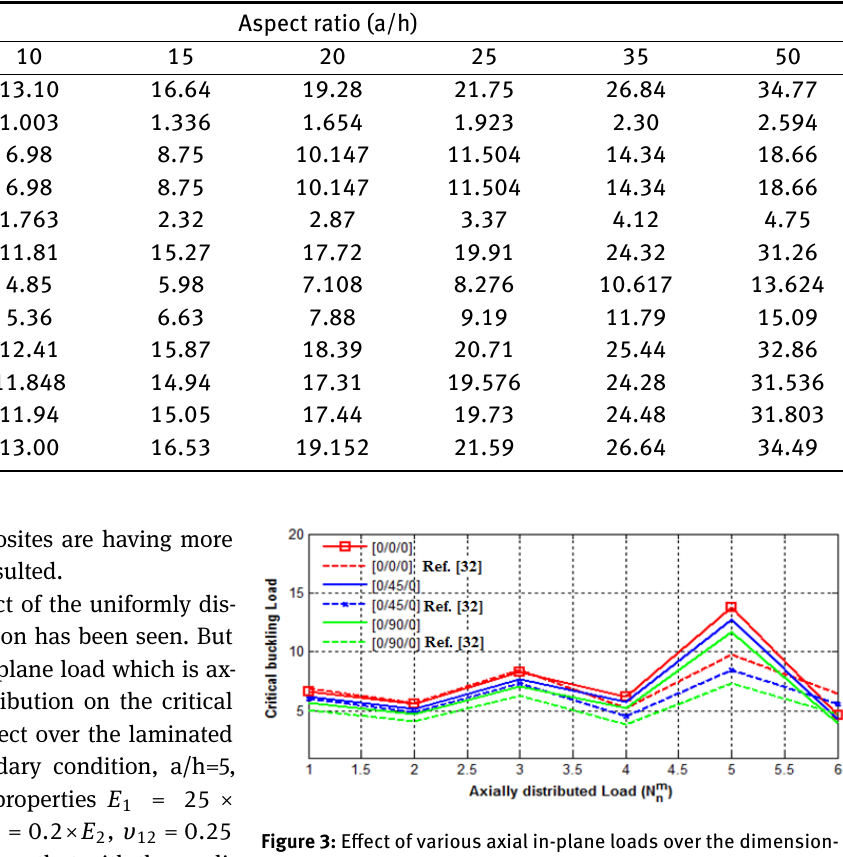
ary condition. When only 0 ∘ and 90 ∘ combination is con- sidered, then observation shows that all fibers orientated along longitudinal direction gives maximum value of crit- ical buckling load and lowest critical buckling load is ob- served when all fibers are oriented in transverse direction to that of applied loading. So precaution should to take that, all fibers are not strictly oriented in 90 ∘ during com- pressive axial distributed loading otherwise beam will get buckled earlier than required. Study also shows that the other ply orientations like 15 ∘ , 45 ∘ , 90 ∘ etc. are